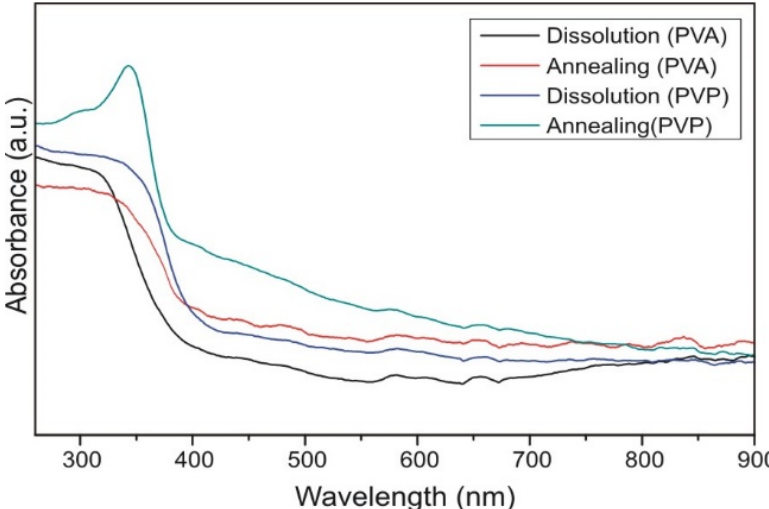
Figure 6. UV-Vis spectra of the TiO 2 nanotubes.